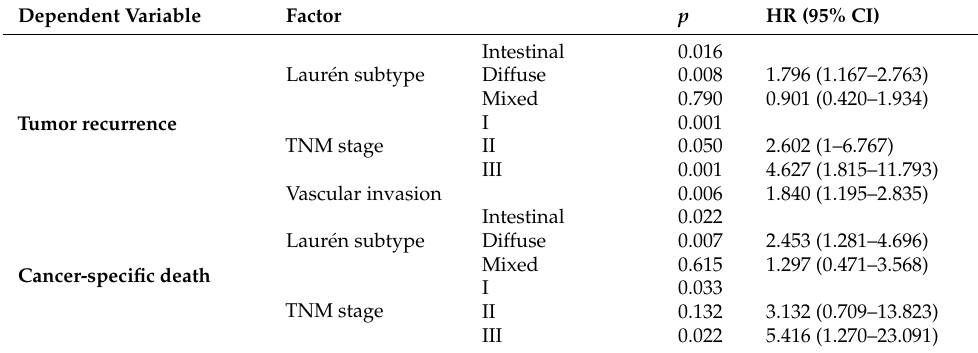
Table 4. Multivariate analysis. Independent risk factors for tumor recurrence and cancer- specific